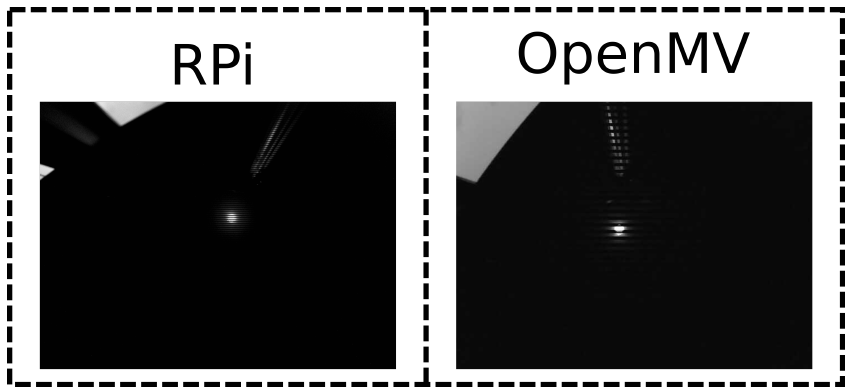
Figure 12. Example images of the same light taken with different